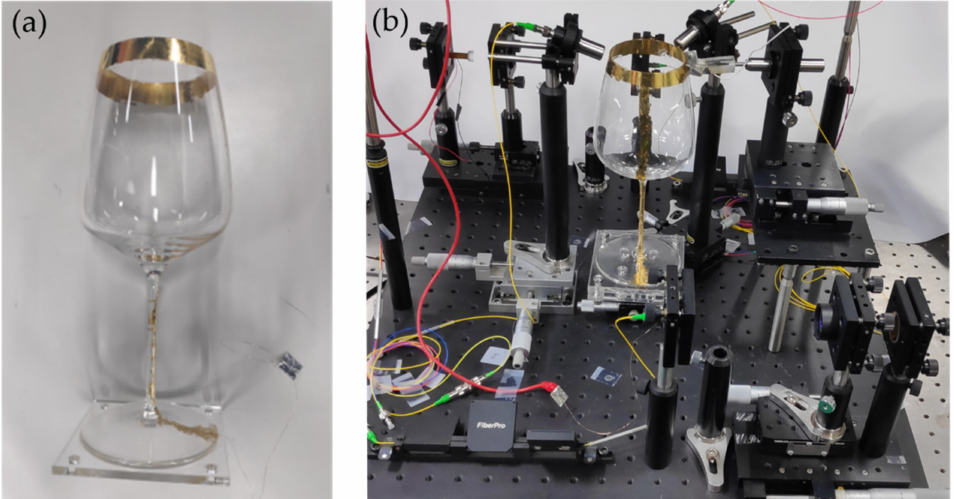
Figure 5. The photographs of ( a ) the hemispherical resonator and ( b ) the rotating part of the implemented HRG system. A general consumer wineglass was used as the resonator. A sheet of thin gold foil was attached and used as the electrode for activating the